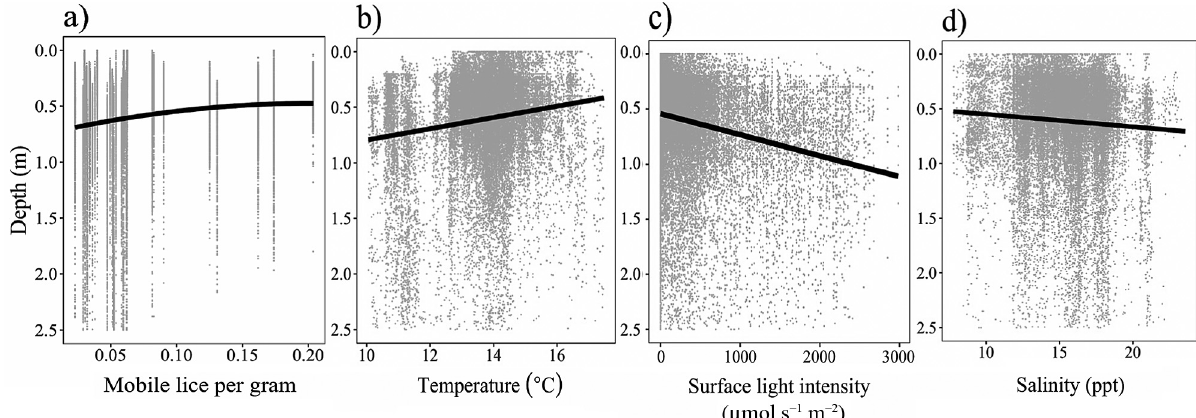
Fig. 3. Plots of predicted Salmo trutta depth against the 4 parameters: (a) mobile lice per gram of fish ( L i MOB ), (b) surface tempera- ture ( T t up ), (c) surface light intensity (log C t ) , and (d) surface salinity ( S t up ), included in the best-fitting model for depth use (Table 3), fitted with a smoothing line (black)